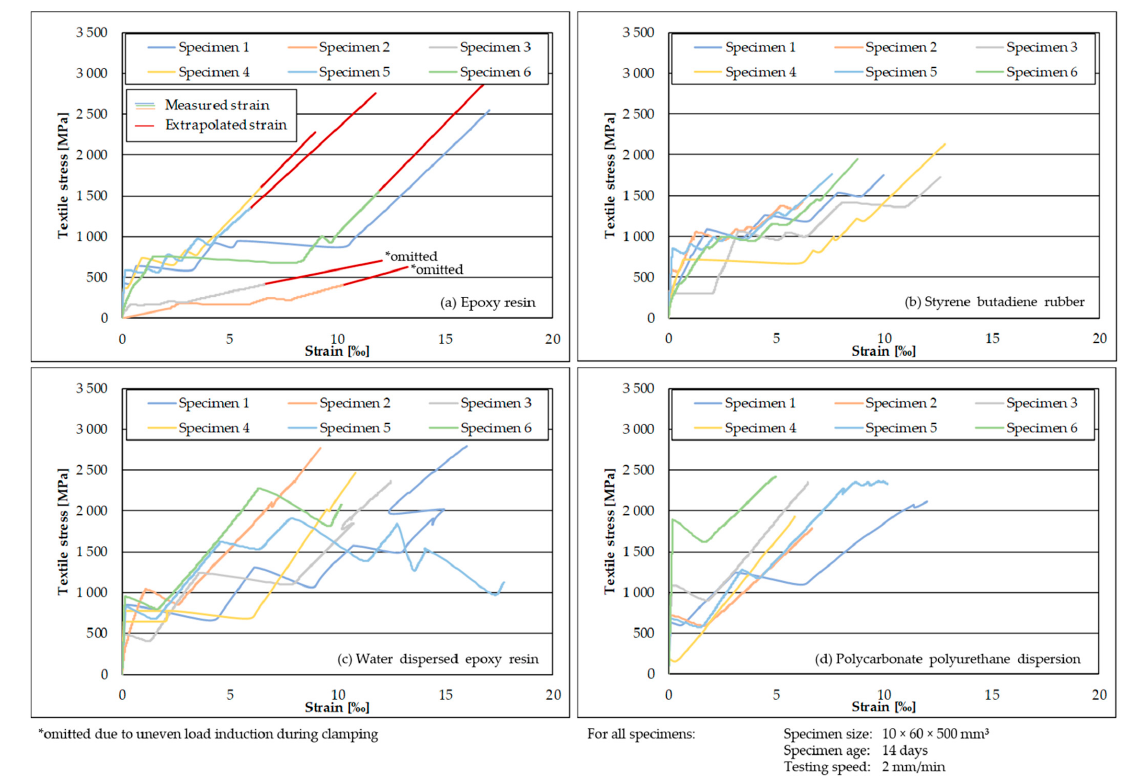
Figure 8. Resulting stress–strain curves of all FoH tensile tests: ( a ) epoxy resin; ( b ) styrene butadiene rubber; ( c ) water-dispersed epoxy resin; ( d ) polycarbonate polyurethane dispersion.